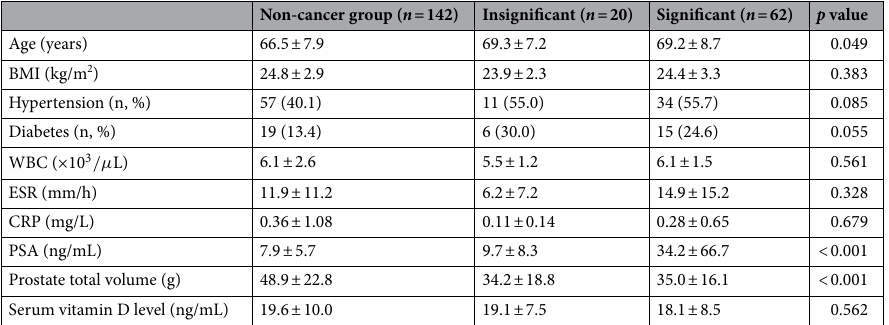
Table 1. Demographic and clinical characteristics of patients. BMI body mass index, WBC white blood cell, ESR erythrocyte sedimentation rate, CRP c-reactive protein, PSA prostate-specific